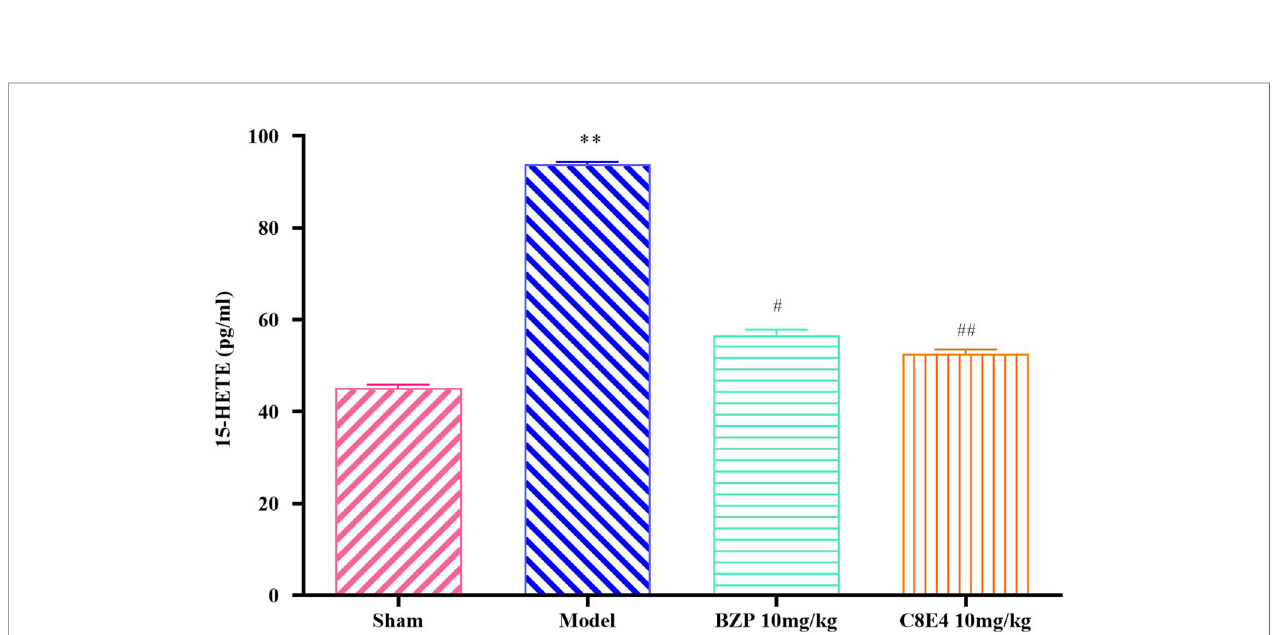
FIGURE 5 | Effect of BZP on 15-HETE levels in MCAO rats. Animals were treated with BZP (10 mg/kg), C8E4 (10 mg/kg) before reperfusion. Data were presented as mean ± sd. One-way ANOVA test was used to determine statistical signi fi cance. ** P < 0.01 vs Sham group; # P < 0.05, ## P < 0.01 vs Model